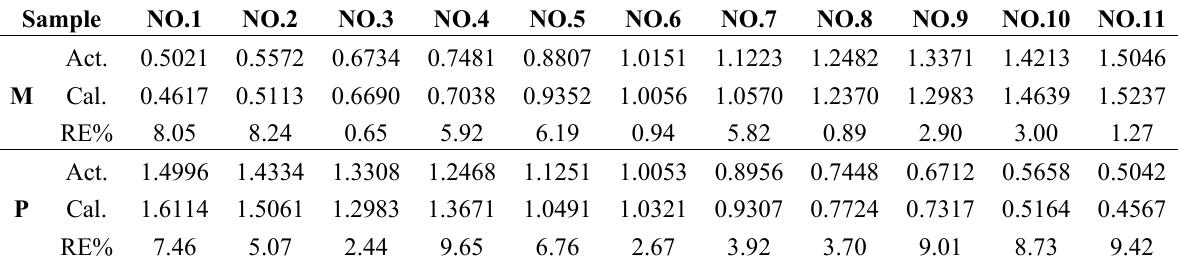
Table 5. The result of analysis of the weight of M and P in GZFLW (g).